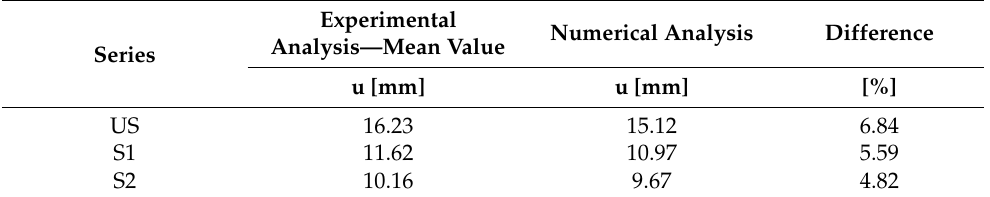
Table 6. A comparison of deflection values using laboratory and numerical methods, for the force value F/2 = 5 kN.